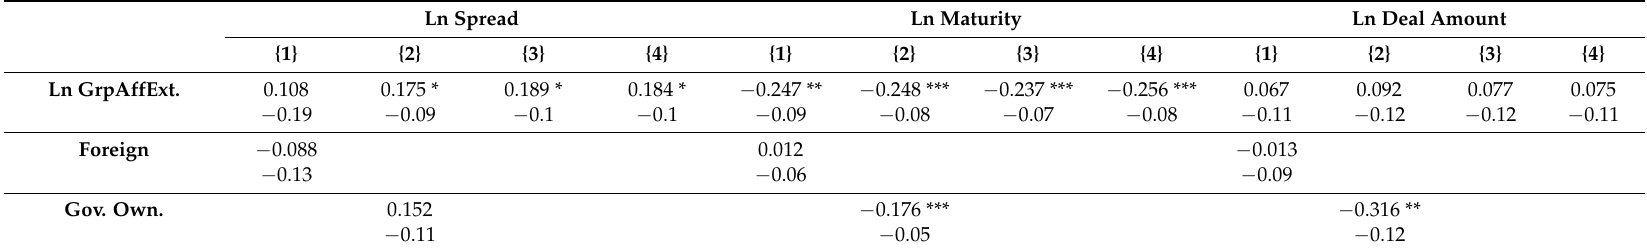
Table 10. OLS regressions of Spread, Maturity and Deal Amount on Group Affiliation Extent, Foreign Ownership, Government Ownership, Financial Firm, Cross-listed, and Borrower and Loan Characteristics. Table 10 presents the pooled ordinary least squares (OLS) regression results of ln (Spread, Maturity, Deal Amount) on Group Affiliation Extent, Foreign Ownership, Government Ownership, Financial Firm, Cross-listed, and Borrower and Loan Characteristics. Group Affiliation Extent is calculated based on the percentage of group ownership in borrower firms (0% indicates that there is no group association, and 100% means that the associated group owns all the firm’s shares). Control variables include firm and loan characteristics, and loan type, year, and industry dummies. They are excluded for brevity. Robust standard errors are reported in parentheses. Each model is clustered at the group level to control for possible group fixed effects. *, **, and *** represent significance levels of 10%, 5%, and 1%